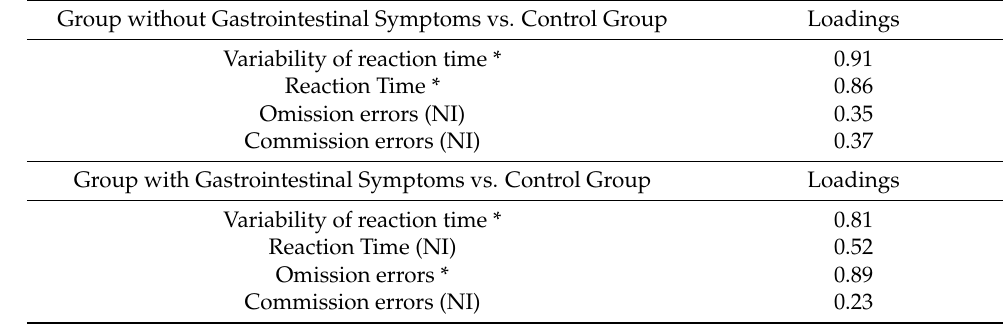
Table 2. Pooled within-group correlations between discriminating variables and standardized canon- ical discriminant